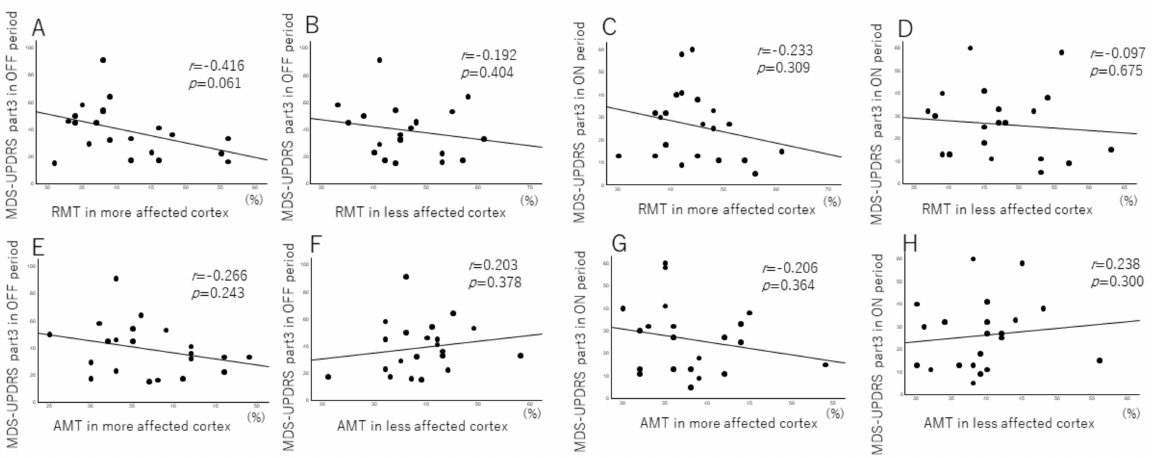
Figure 2. Correlation between the transcranial magnetic stimulation parameter and the motor symptoms as per the Movement Disorder Society Unified Parkinson’s Disease Rating Scale (MDS- UPDRS) part 3. ( A ) Resting motor thresholds (RMTs) in the more affected cortex were correlated with the MDS-UPDRS part 3 in the OFF period. ( B ) RMT in the less affected cortex was not correlated with the MDS-UPDRS part 3 in the OFF period. ( C , D ) RMT was not correlated with the MDS-UPDRS part 3 in the ON period. ( E – H ) Active motor thresholds (AMT) in more and less affected cortex were not correlated in the ON and OFF periods.